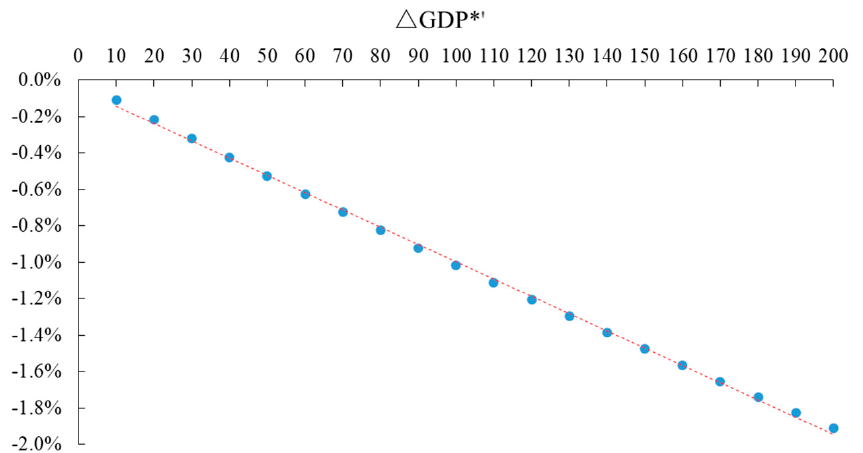
Figure 4. Different rates of carbon tax and the change rate of total GDP.